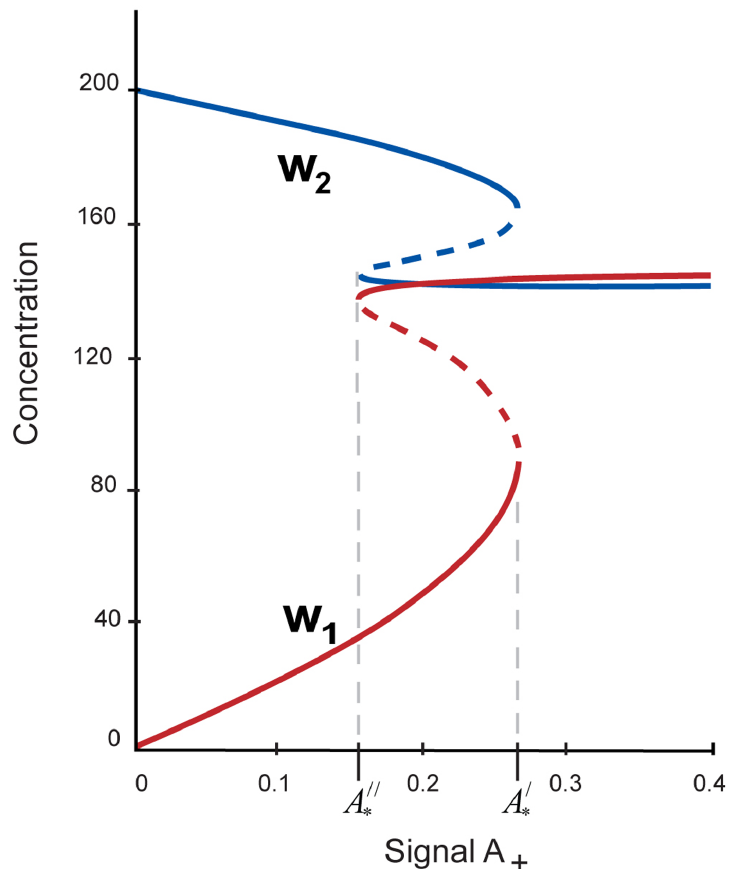
Fig 7. Steady state behavior of the PTGs and DTGs as functions of the parameter A upon h = 6 , a Abscissas of the turning points of w 1 and w 2 curves with values A jj the bistable behavior (marked by asterisks). As the parameter A is boosted beyond A j switches to the pluripotent state, while when the external signal is dropped below A jj differentiation